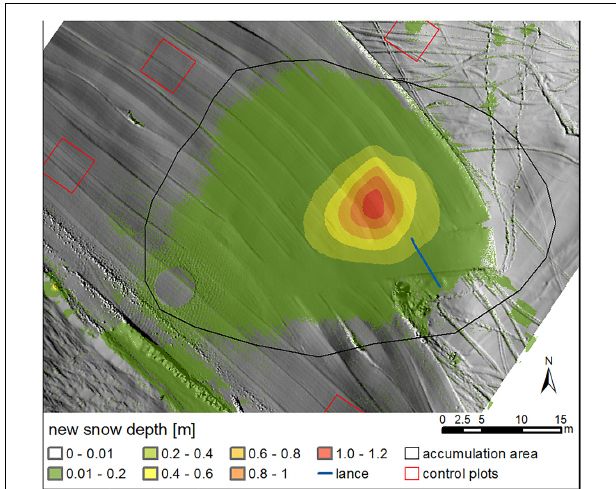
FIGURE 4 | Height of the produced snow measured by terrestrial laser scanning for February 11/12, 2016. The black line marks the accumulation area deduced from dGNSS measurements of the visually recognized snow deposition. Red squares show examples for control